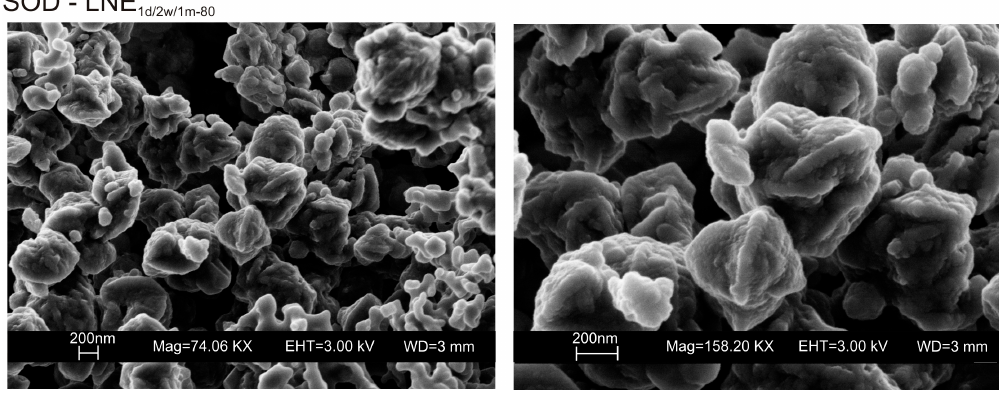
Figure 8. SEM images of sodalite formed in LNE samples.